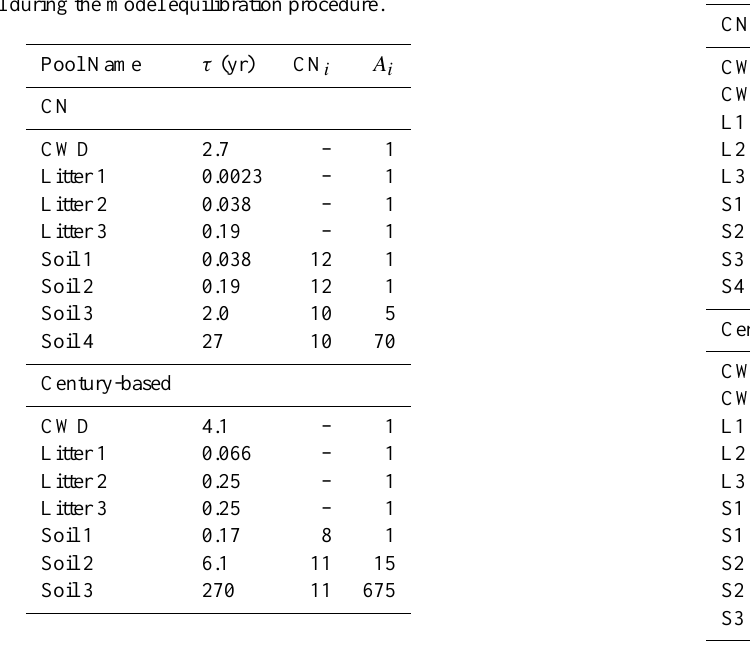
Table 1. Pool characteristics for the two decomposition structures used in this paper. Turnover times, τ , are for reference conditions of 25C and no moisture or oxygen limitations. CN i is the C:N ratio for each pool. A i is the factor of accelerated decomposition used for each pool during the model equilibration procedure.